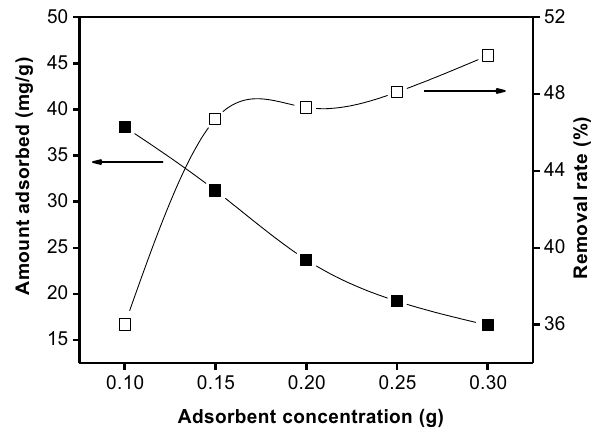
Fig. 5 The effect of DES/H 3 PO 4 -600 2:3 dosage on adsorption Pb(II) ([Pb] o = 50 mg/L, time = 1 h.30 min